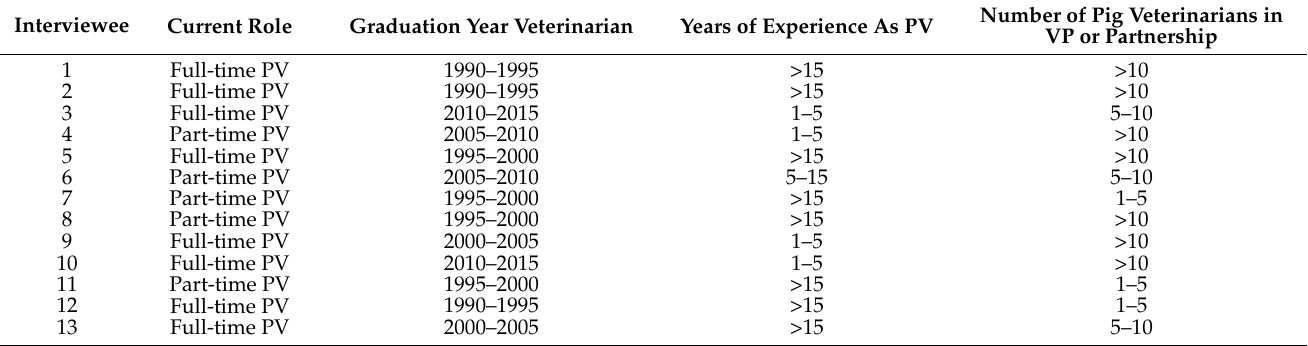
Table 1. Details of participants (veterinarians) interviewed in the study: “Why Veterinarians (Do